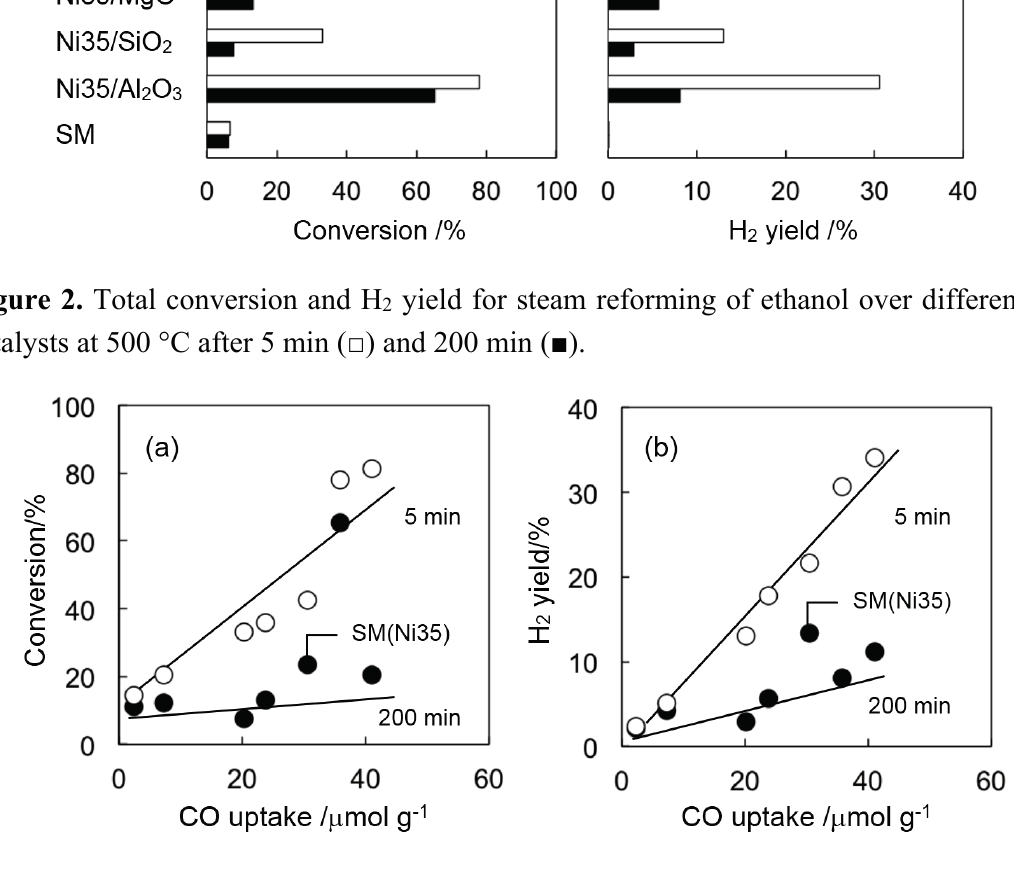
Figure 3. Relationship between the amount of surface Ni (CO uptake measured by CO chemisorption) and either total conversion ( a ) or H 2 yield ( b ) after the reaction time of 5 min ( ○ ) and 200 min ( ●